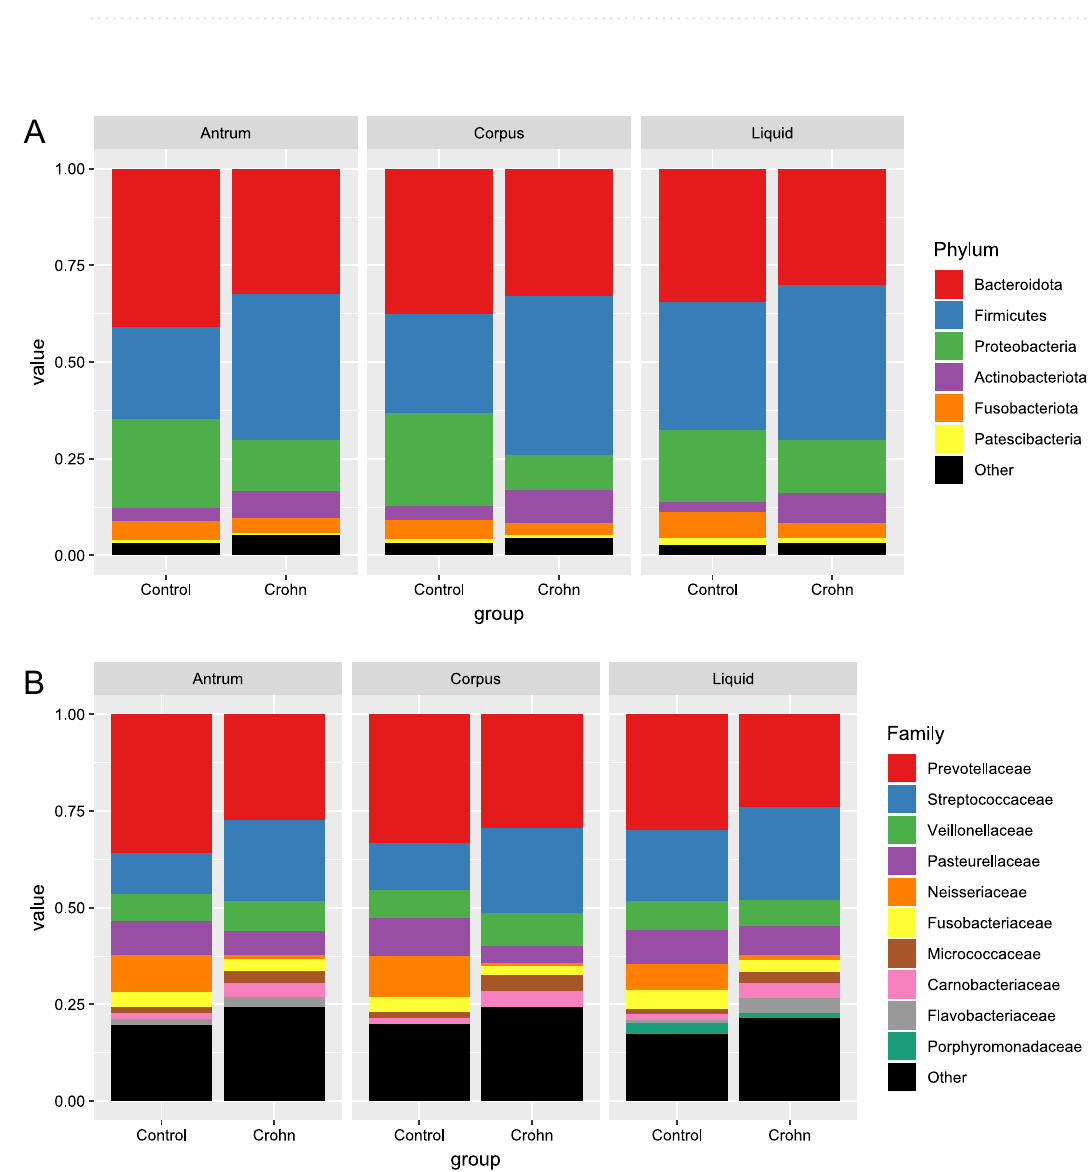
Table 2. The top ten most abundant phyla, and their relative abundance, in all three types of gastric samples.